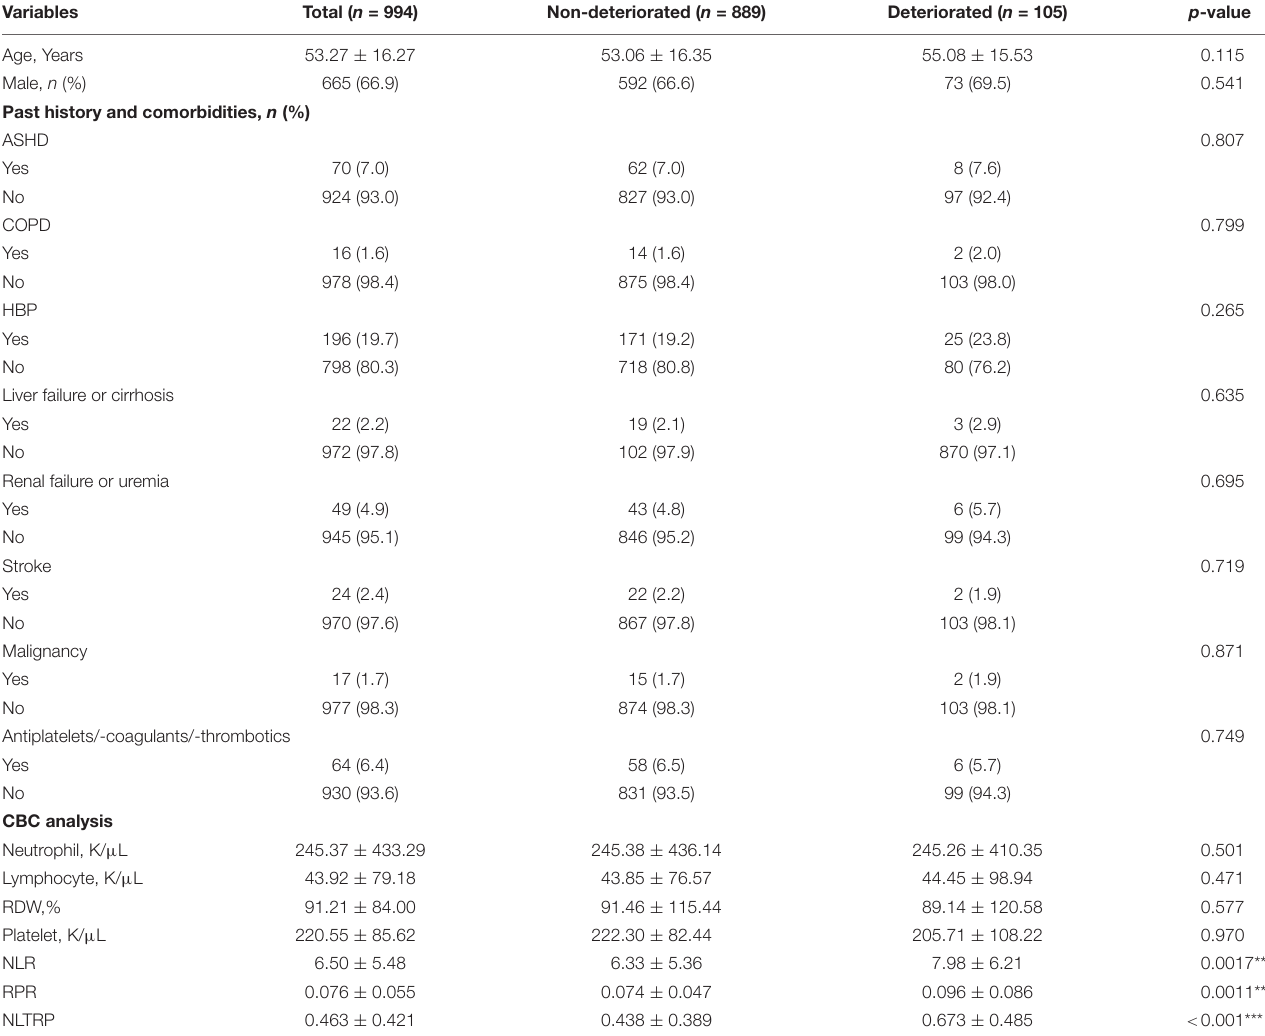
TABLE 1 | Baseline characteristics of the patients with